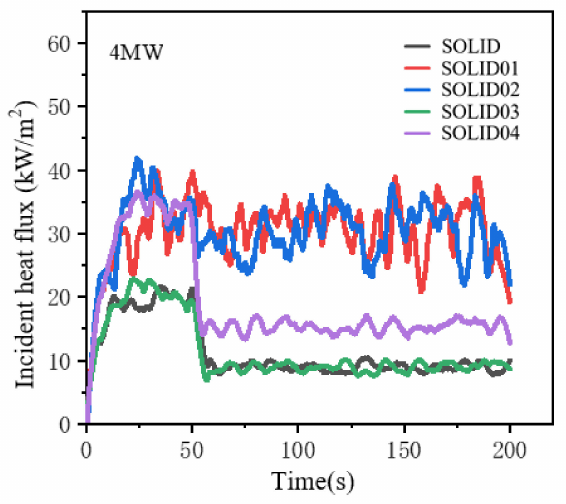
Figure 24. Glass incident heat flux variation under window sprinkler